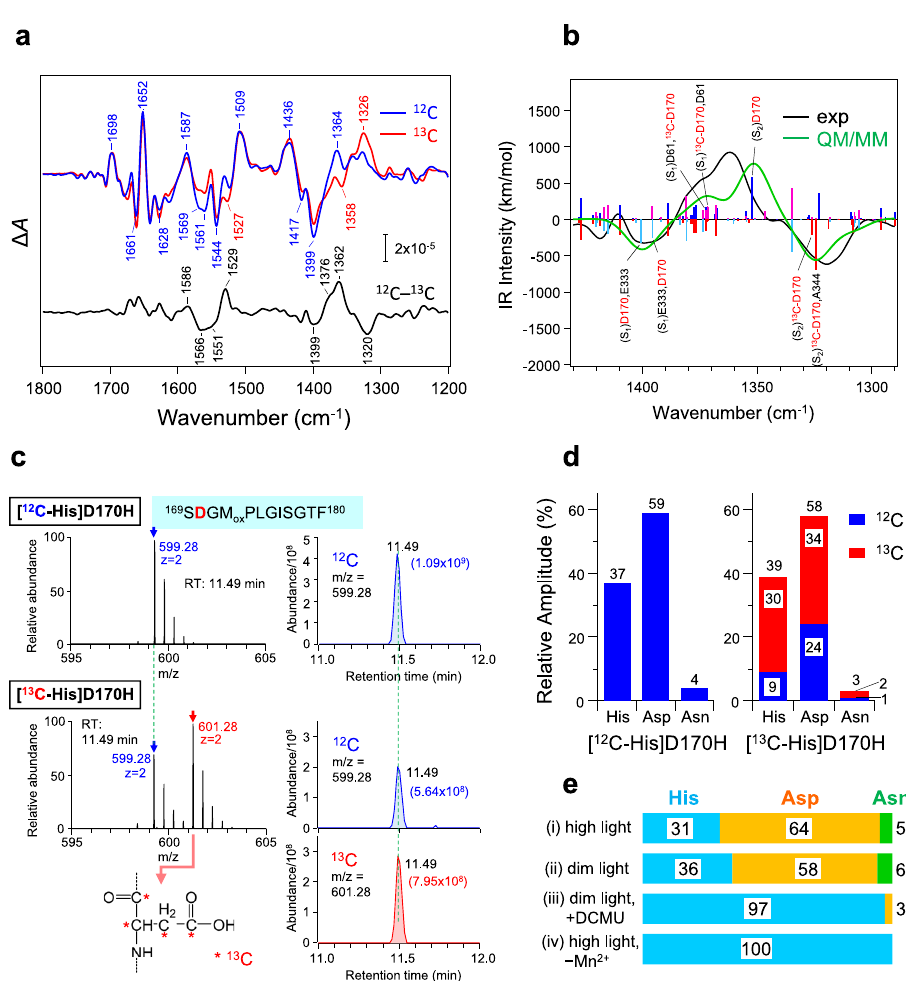
Fig. 2 FTIR and LC-MS analyses of the D1-D170H mutant. a Flash-induced S 2 /S 1 FTIR difference spectra of the PSII complexes from D1-D170H cells incorporated with unlabeled ([ 12 C-His]D170H: blue line) and 13 C 6 -labeled histidine ([ 13 C-His]D170H: red line), together with a 12 C-minus- 13 C double difference spectrum (black line). b The 12 C-minus- 13 C infrared difference spectrum simulated by QM/MM calculations (green line) in comparison with the experimental spectrum (black line). The normal modes of the unlabeled (S 1 : cyan sticks; S 2 : blue sticks) and 13 C-D170-labeled (S 1 : magenta sticks; S 2 : red sticks) OEC are superimposed. c MS spectra (left) and MS chromatograms (right) of the polypeptide fragments of the D1 proteins (between S169 and F180 with oxidized M172) in [ 12 C-His]D170H and [ 13 C-His]D170H cells. The data of the D1 fragment that has Asp at position 170 are shown. A peak of the target polypeptide fragment in the MS spectrum is indicated by a blue ( 12 C-D170) or red ( 13 C-D170) arrow. The area intensity of the chromatogram peak is given in parentheses. d LC-MS estimation of the relative amounts of the D1 fragments having His, Asp, and Asn residues at position 170 with 12 C